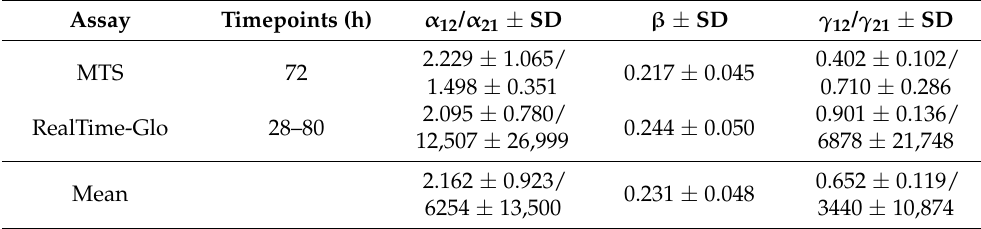
Table 5. Drug interaction between Siremadlin and Trametinib in A375 cells. For MTS assay, n = 4, and for RealTime-Glo assay, n = 3. Synergy package